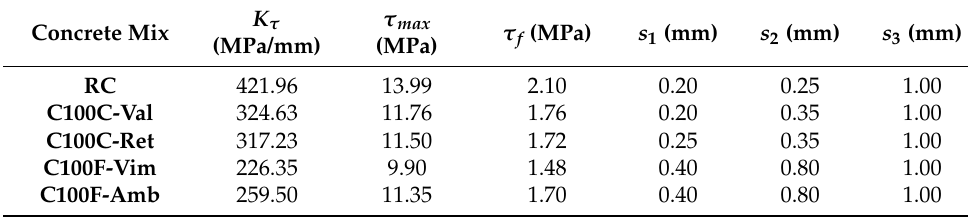
Table 9. Bond-slip properties adopted in the